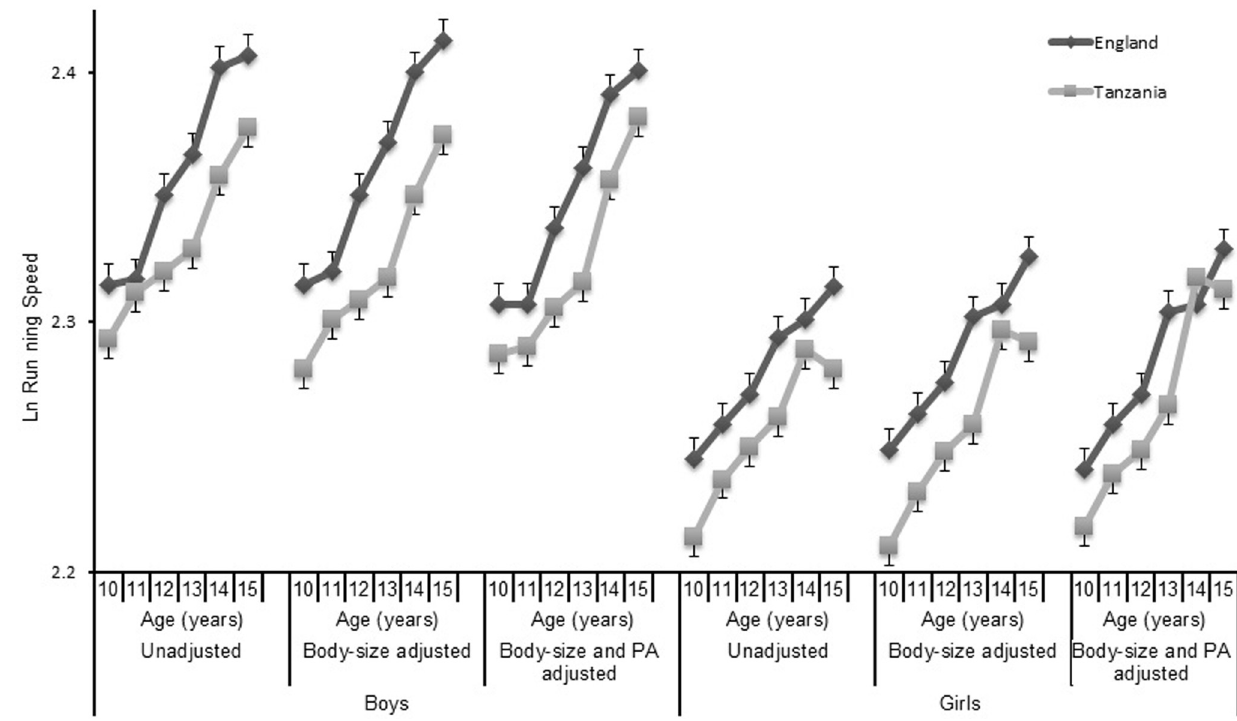
Fig 4. Differences in running speed of English and Tanzanian schoolchildren adjusting for body size and physical activity. Ln—natural logarithm. Running speed is Ln speed (km/h) of last completed stage during the 20 m shuttle-run test. Body-size adjustments made using allometric scaling for Ln (mass) and Ln(stature). PA-Physical Activity–assessed from self-report using the Physical Activity Questionnaire for Children or Adolescents.